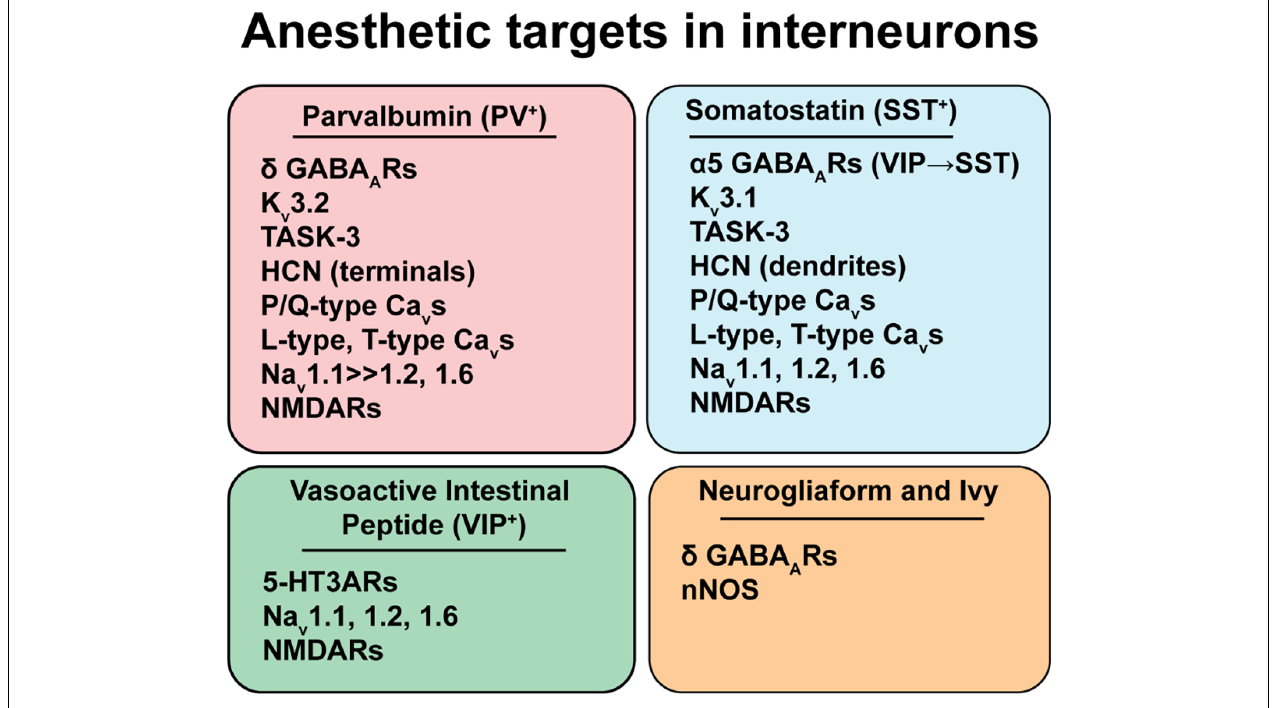
FIGURE 2 | Anesthetic targets in interneurons. Highlighted anesthetic targets that are differentially expressed amongst the prominent interneuron subtypes from Figure 1 . Anesthetic effects on specific targets and cells are complex and anesthetic agent-specific, so they are not shown in the figure. Please see the text for a discussion of the direction, potency, and implications of specific anesthetic effects. Abbreviations: GABA ARs , γ -aminobutyric acid type A receptors; K v 3.1/K v 3.2, voltage-gated potassium channels; TASK-3, TWIK-related acid-sensitive potassium channel subtype 3; HCN, Hyperpolarization-activated cyclic nucleotide-gated channels; Na v , voltage-gated sodium channels, with the Na v 1.1 subtype being more abundant in PV + interneurons; NMDAR s , N-methyl-D-aspartate receptors; 5-HT3